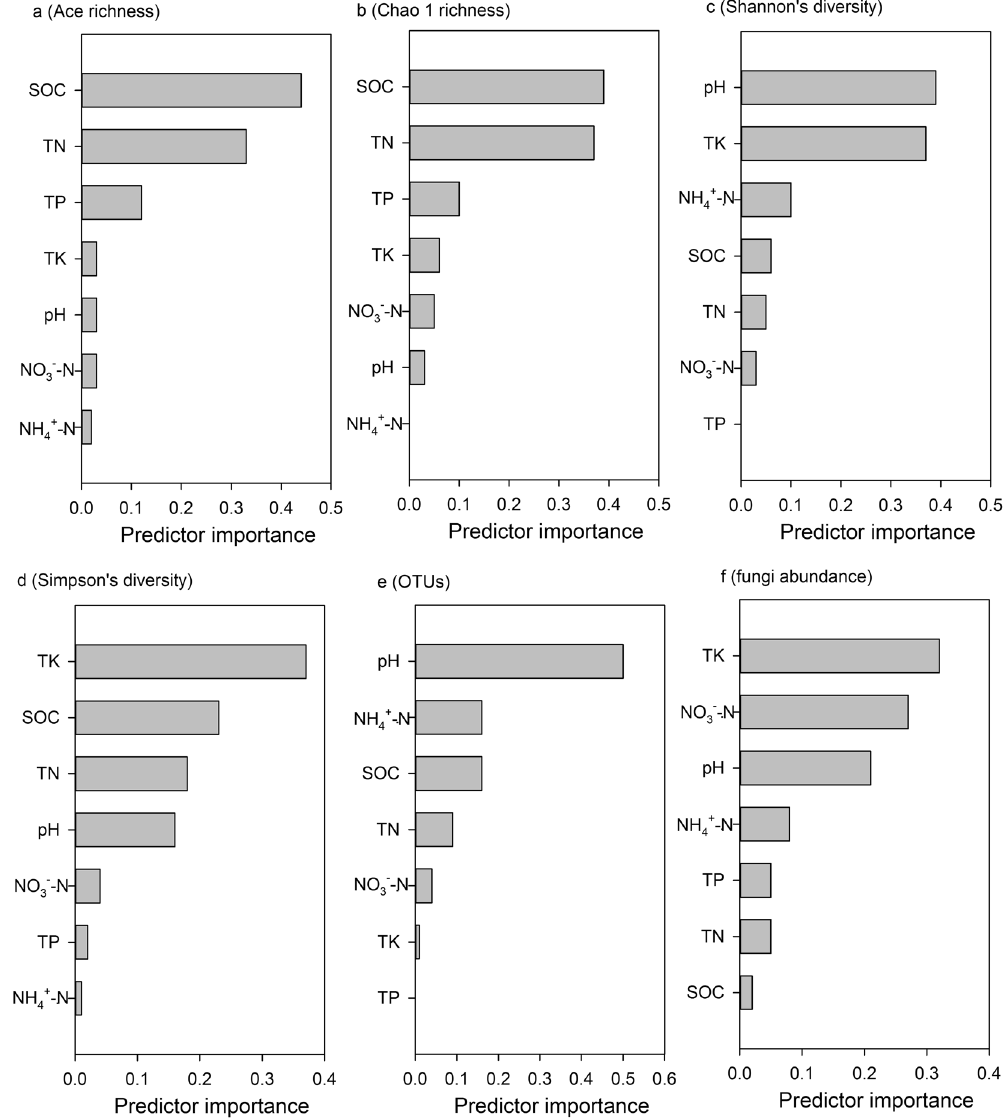
Figure 4. Predictive importance of each soil chemical property to ( a ) Ace richness, ( b ) Chao 1 richness, ( c ) Shannon’s diversity, ( d ) Simpson’s diversity, ( e ) the number of OTUs and, ( f ) fungal abundance determined by automatic linear